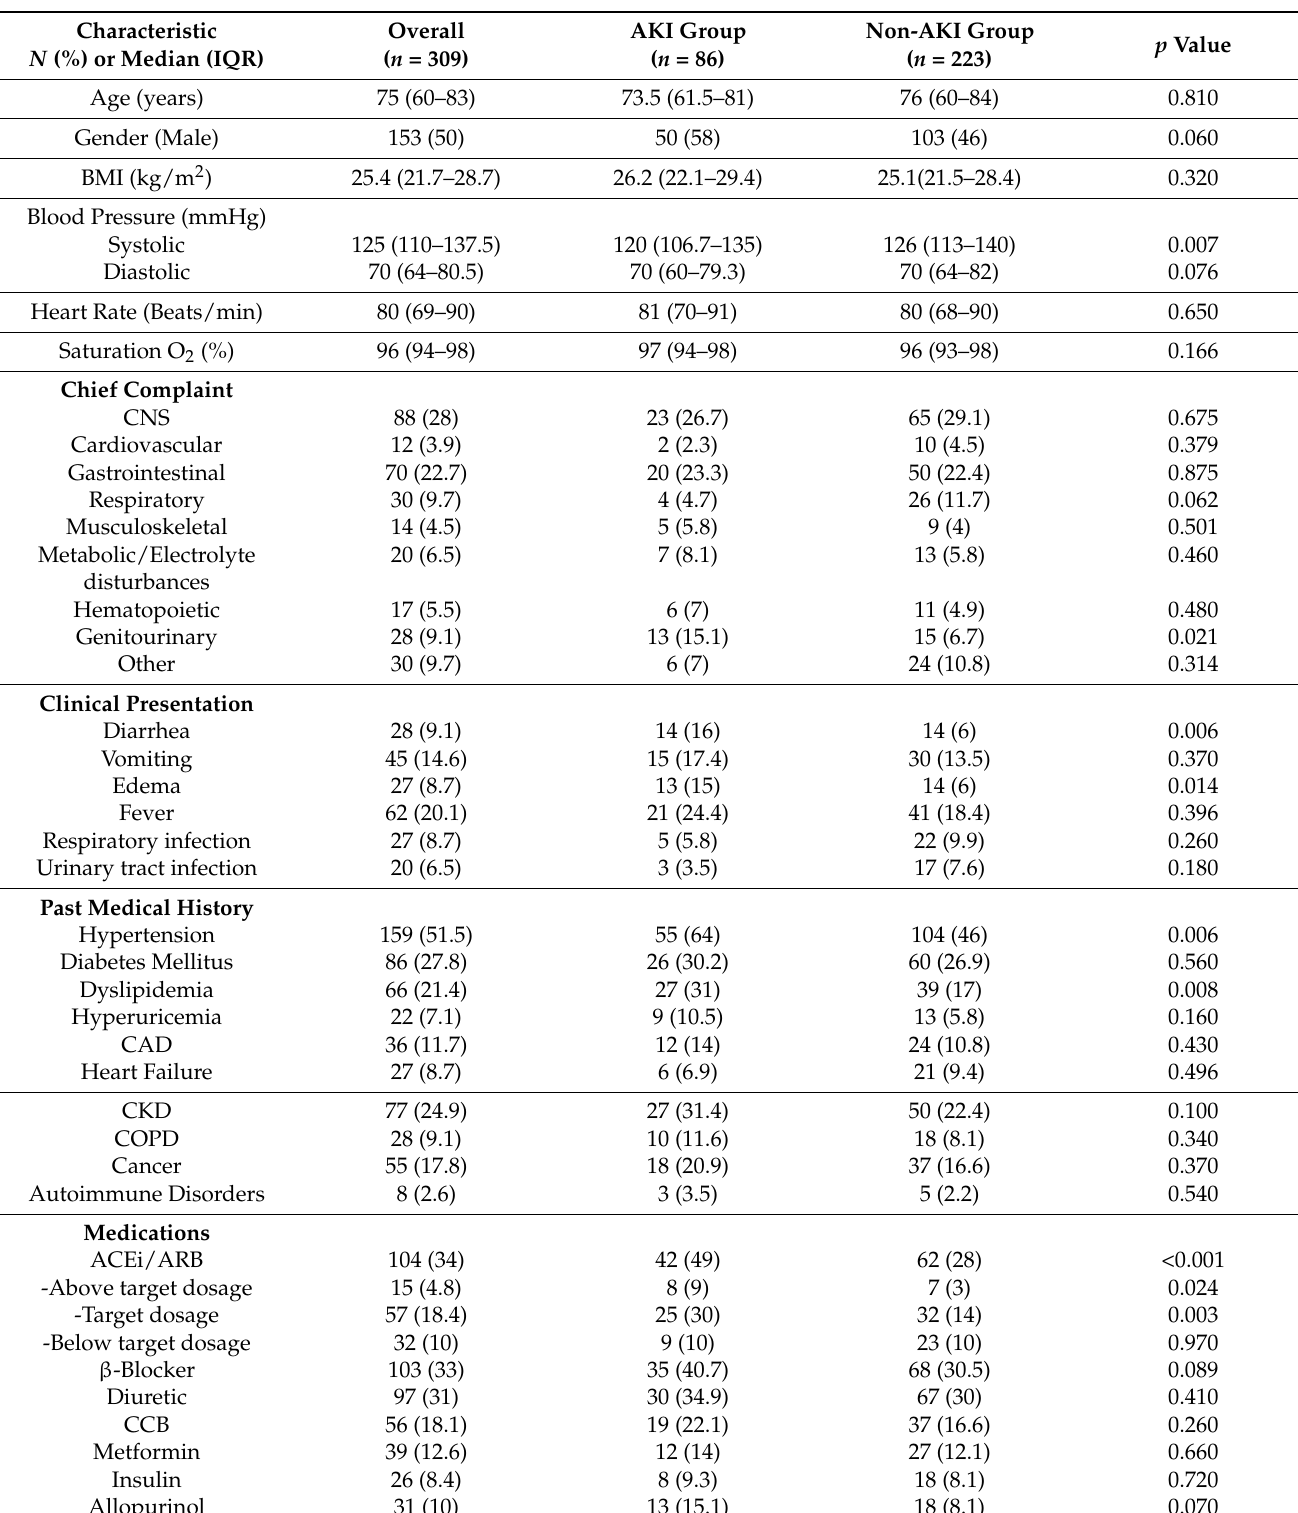
Table 2. Comparison of demographic and clinical characteristics of the emergency medical admissions according to the development of